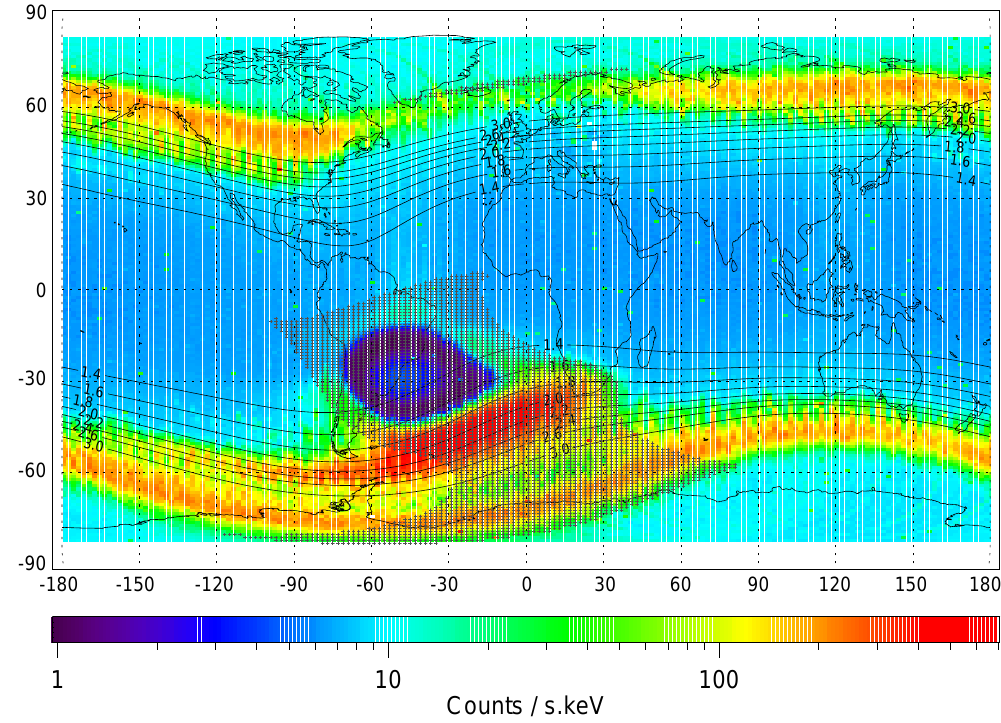
Fig. 1. The colored geographical map of average counts for 60–150keV X-rays measured by CORONAS-F throughout October–December, 2002 in the altitude range of 440–490km. Note in the South Atlantic Anomaly the SONG instrument was saturated by high fluxes of energetic ( > 50MeV) protons (purple and blue). The footprints of several L shells between 1.4 and 3.0 and the region of stable trapping (crosshatched) at 500km are shown for reference. The location of the stable trapping area at an altitude of 500km is adopted from Buˇc´ık et al. (2005). It consists of set of L , B values (determined by IGRF 1990), for which the minimum longitude traced altitude is above 100km. Small white strips in the Eastern Europe mean no data available for these regions, due to operative controls when the satellite passed over Moscow. Note that the adjacent region is characterized by a reduction in the amount of data. There are less than 10 records per bin in the area clustered at longitudes 20 ◦ –30 ◦ and latitudes 40 ◦ –60 ◦